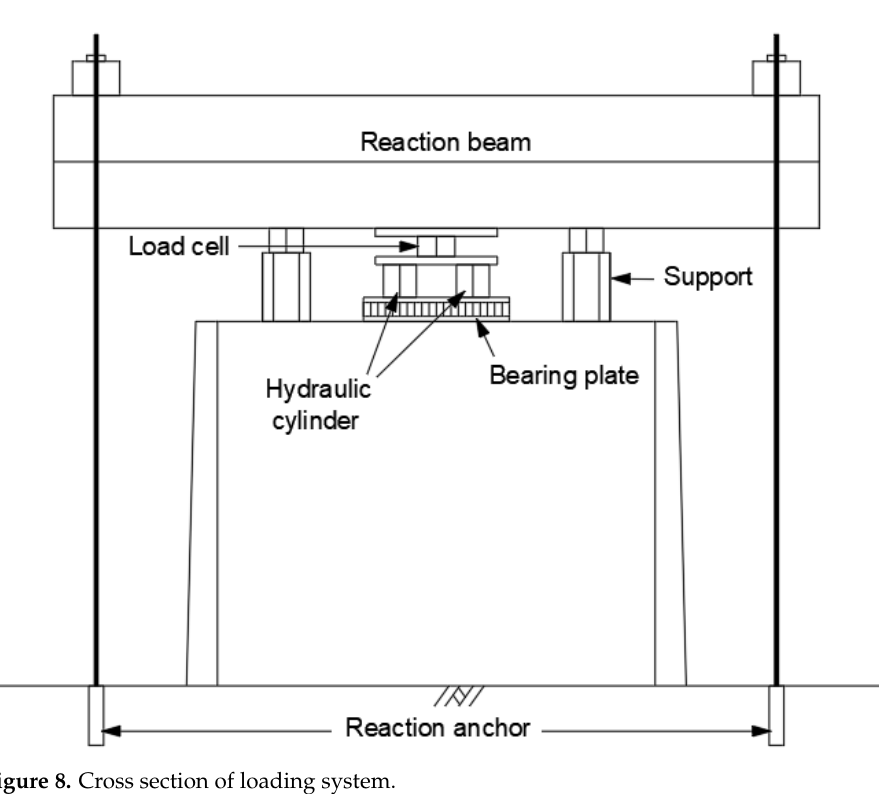
Figure 8. Cross section of loading system.